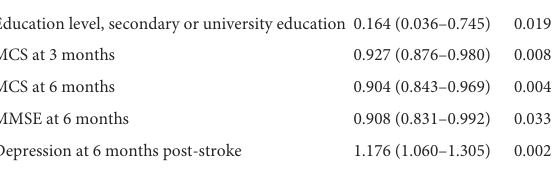
TABLE 5 Independent predictors of 1-year stroke recurrence using cox proportional hazard regression multivariable